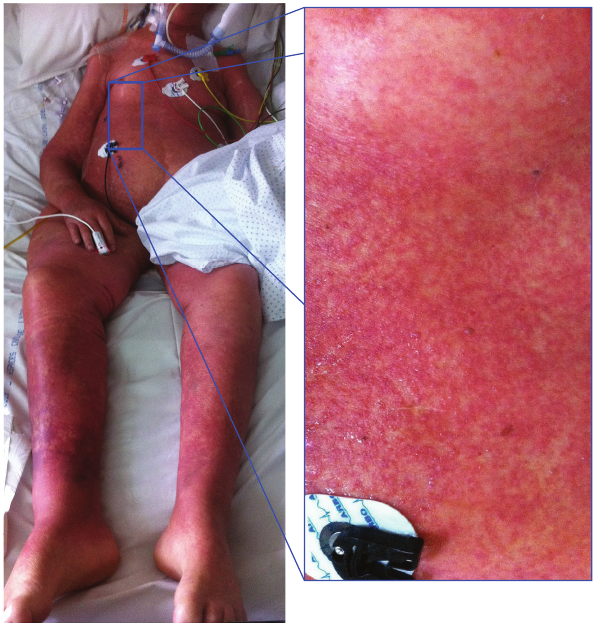
Figure 2: Erythrodermia in ICU ventilated patient. Focus on the chest showing a maculopapular